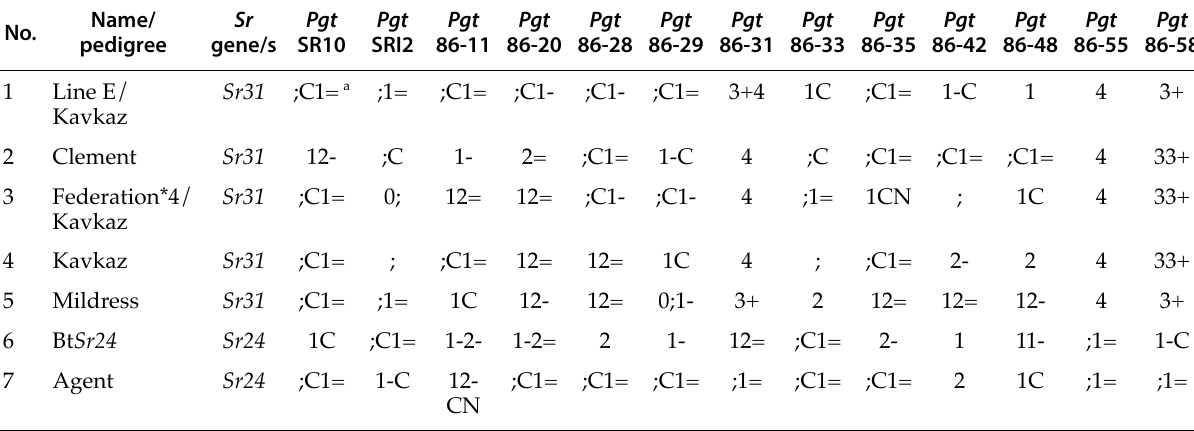
Table 2. Seedling infection types of wheat lines in the ‘Quickset’ used to assay the effectiveness of Sr31 to 13 Puccinia graminis f. sp. tritici collections.